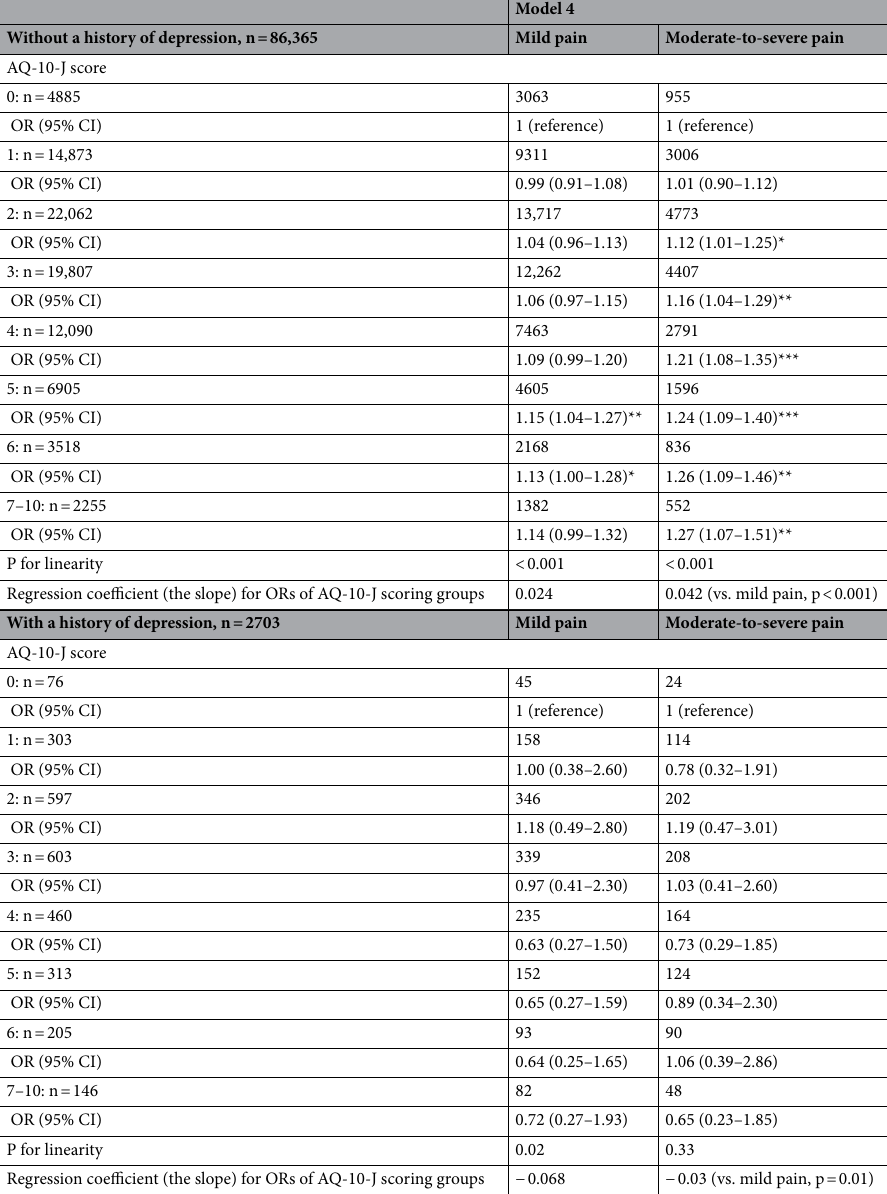
Table 3. Odds ratios (95% confidence intervals) for antenatal pain by Autism-Spectrum Quotient short form (Japanese version) scoring group: stratification by the presence of a history of depression. AQ-10-J Japanese version of the Autism-Spectrum Quotient short form, CI confidence interval, OR odds ratio. Model 4: Adjusted for age, pre-pregnancy body mass index, smoking during pregnancy, drinking during pregnancy, physical activity, education, marital status, equivalized income, employment status, multiple pregnancy. History of delivery, history of anxiety disorder, history of schizophrenia, history of other psychological disorders, feeling when pregnancy was found out, sleep depth, and psychological distress. The Kessler Psychological Distress Scale (K6) score ≥ 13 was interpreted as indicating the presence of psychological distress during pregnancy. Odds ratio was estimated by multinominal logistic regression analysis. P for linearity for the ORs for mild and moderate-to-severe pain by increase in AQ-10-J score were estimated using a general linear model. Regression coefficients for the ORs in the AQ-10-J scoring groups (i.e., slopes) between mild pain and moderate-to-severe pain were also tested using a general linear model. *p < 0.05, **p < 0.01, ***p <